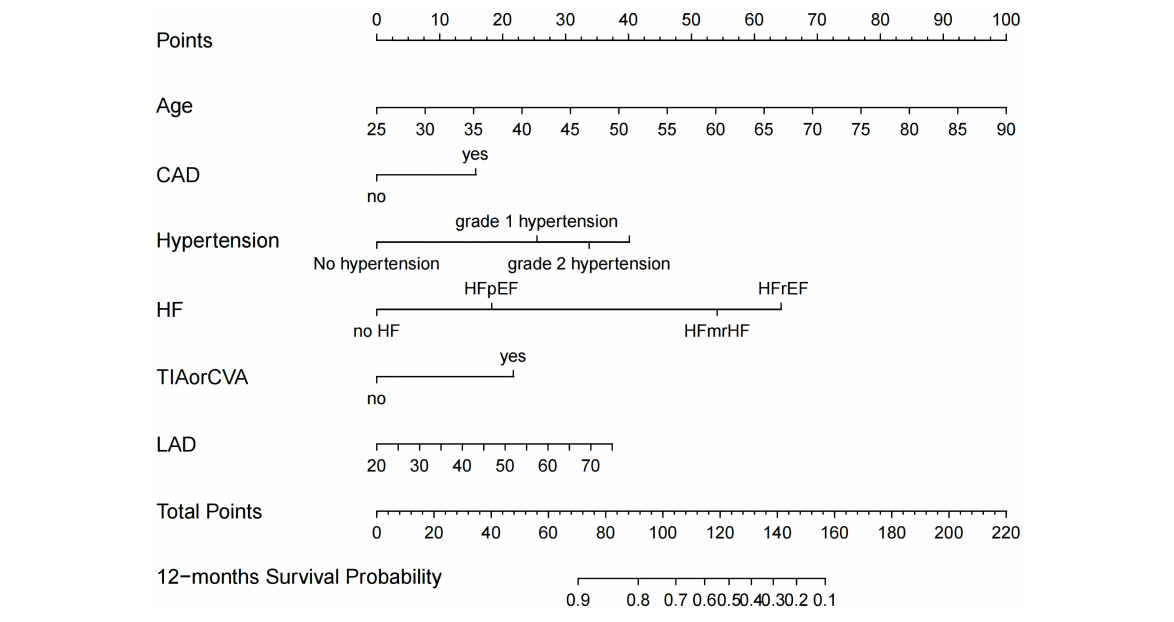
FIGURE2 Nomogram for predicting atrial fibrillation (AF)-free survival probability between 3 and 12 months after radiofrequency catheter ablation (RFCA). CAD, coronary artery disease; HFrEF, heart failure with reduced ejection fraction; HFmrEF, heart failure with mid-range ejection fraction; HFpEF, heart failure with preserved ejection fraction; TIA, transient ischemic attack; CVA, cerebrovascular accident; LAD, left atrial diameter.